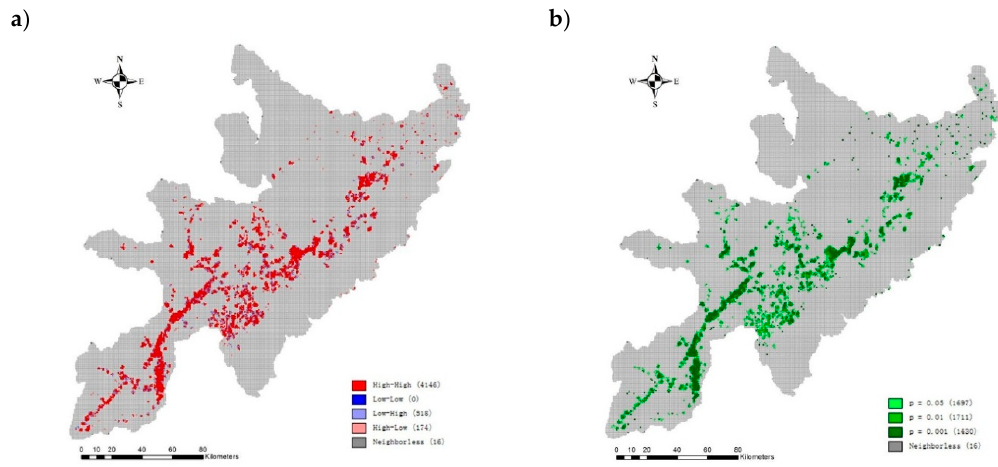
Figure 5. Cluster ( a ) and significance ( b ) maps of local indicators of spatial association (LISA) for all damaged vegetation at the 1 × 1 aggregation level.